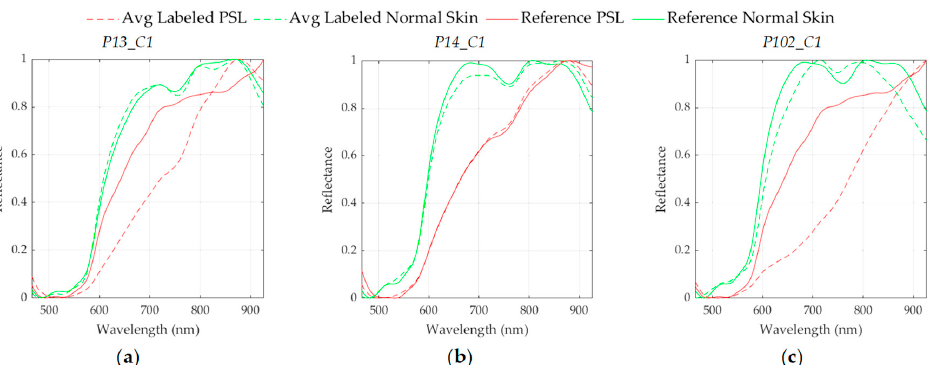
Figure 17. Average spectral signatures of the labeled PSL (dashed red line) and normal skin (dashed green line) pixels, and reference spectral signatures of PSLs (red line) and normal skin (green line). ( a ) P13_C1 (malignant PSL). ( b ) P14_C1 (benign PSL). ( c ) P102_C1 (malignant PSL).